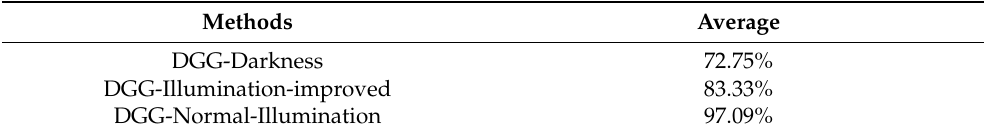
Table 5. The ‘ACC’ results among the darkness, illumination-improved, and the normal bright conditions for View 1 of the PETS2009